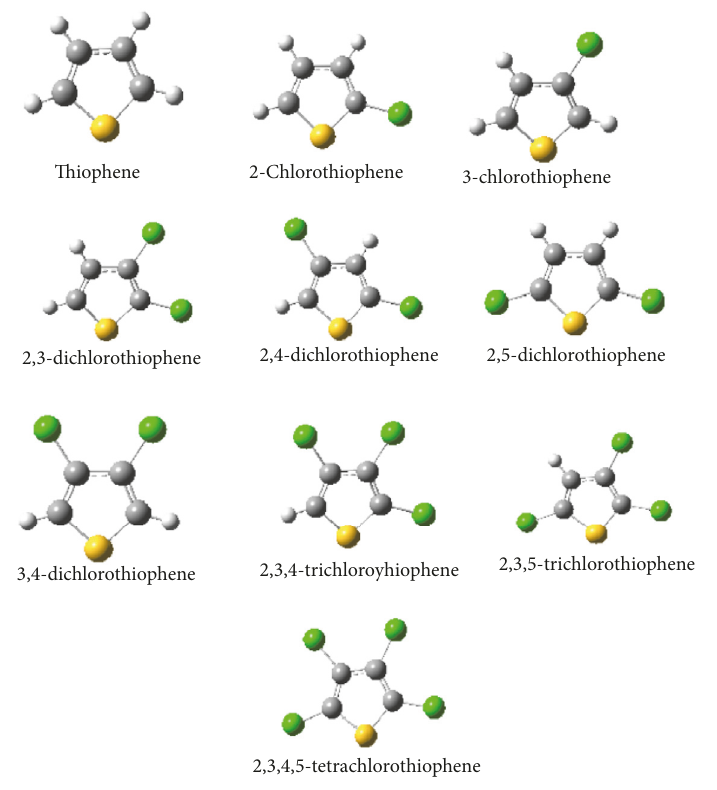
Figure 1: Optimized structures at the B3LYP/6-311+G(d,p) level of theory for chlorinated isomers of thiophene.